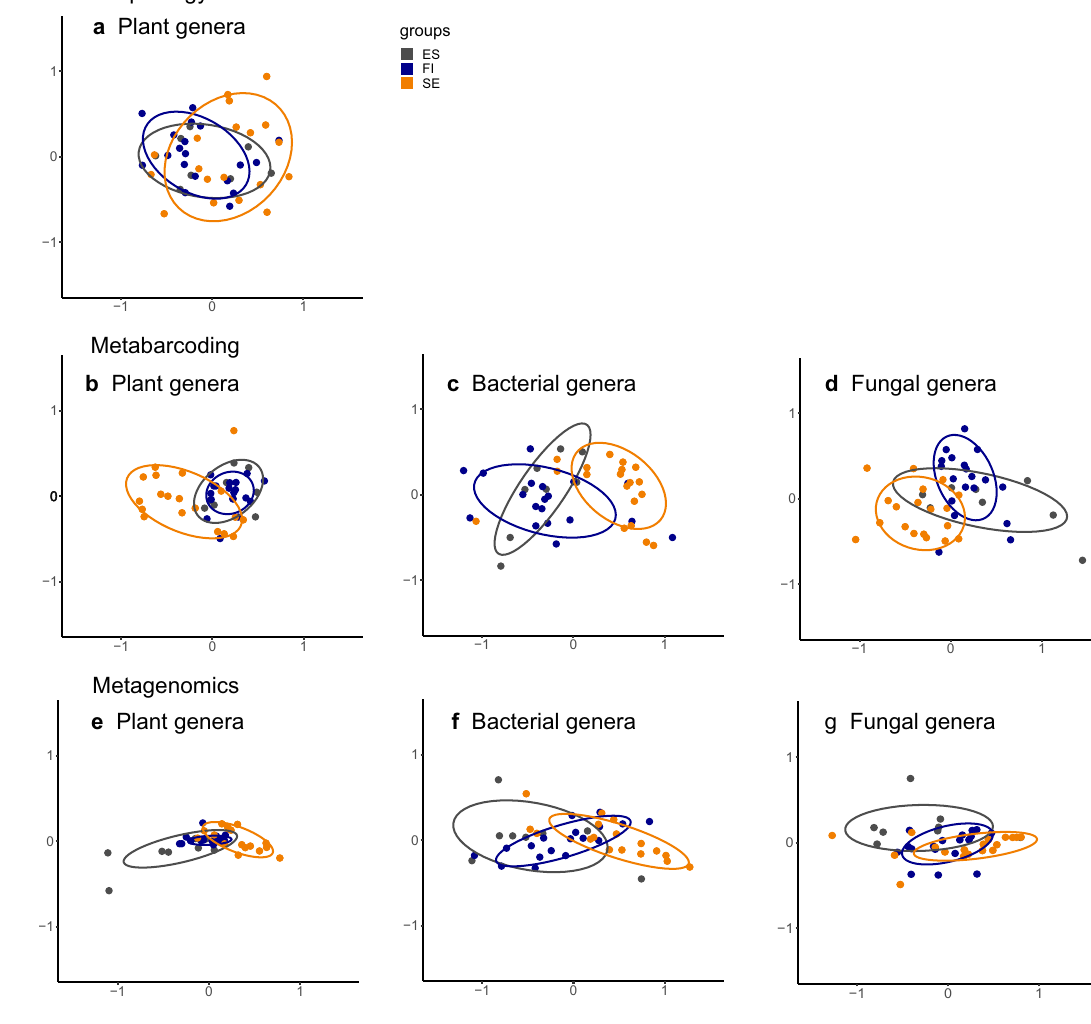
Figure 3. Nonmetric multidimensional scaling (NMDS) plots for plant, bacterial and fungal genera composition similarities among samples originating from the three different countries. The ellipses confine 75% of the data points. Stress values for the different gene region analyses are given in Supplementary Table S4. The panels show the data from different methods morphology ( a ), metabarcoding ( b – d ) and metagenomics ( e – g ), for different taxonomic groups: ( a ), ( b ) and ( e ) plants, ( c ) and ( f ) bacteria and ( d ) and ( g ) fungi. The samples from Estonia (ES) are shown in grey, from Finland (FI) in blue and from Sweden (SE) in light